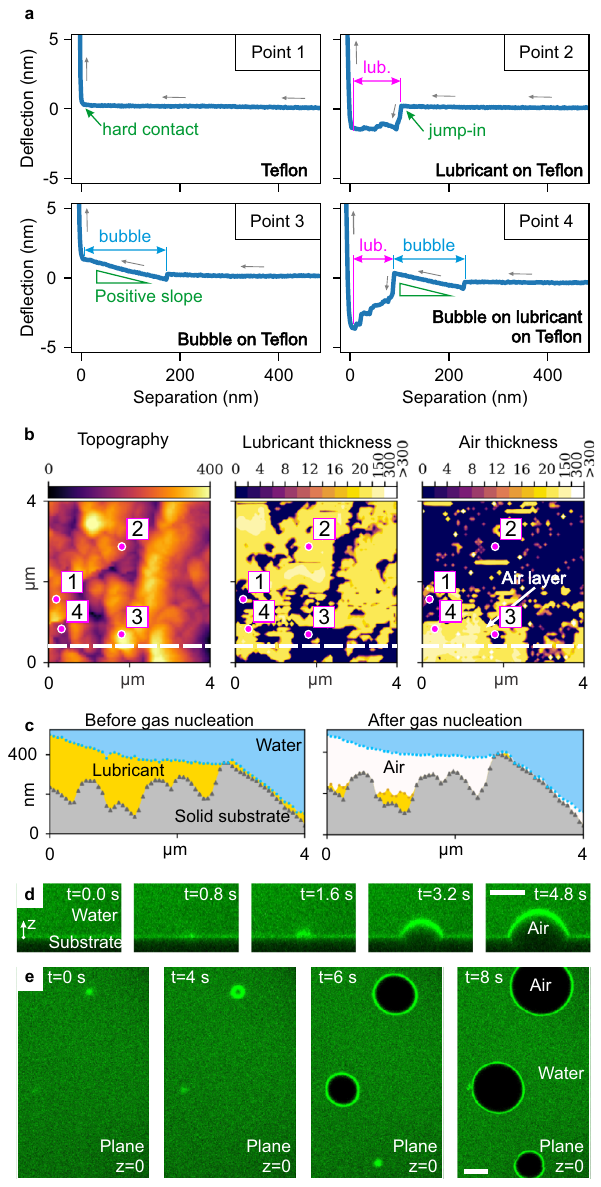
Fig. 4 Evidence of nanobubble nucleation on lubricant-infused surfaces under water. a Atomic force microscopy (AFM) force curves indicating the de fl ection of the cantilever in the points marked on part ( b ). b AFM map of an infused Te fl on-wrinkled surface under Milli-Q water ( c air ~ 23.0 ± 0.3 mg kg − 1 ). The left panel shows the topography of the wrinkles; the middle shows the thickness of the lubricant and the right the air layer, as calculated by the analysis script (further details are contained in “ Methods ” and in the Supporting Information) 27 . The scale bars are in nm. c Cross-sections of the wrinkled surface before (left) and after (right) nanobubble nucleation, reconstructed along the dashed line from the pro fi le in Supplementary Fig. S10a and part ( b ), respectively. Colors have been added to represent the different phases. d Laser confocal microscopy time-lapse of oil-infused Te fl on wrinkles in the presence of highly gassed water with c air ~ 65 ± 7 mg kg − 1 , showing the nucleation of a bubble over time. e Top view of bubble nucleation process over multiple sites. Scale bars are 25 μ m. The full-time sequence is shown in Supplementary Fig. S9. Source data are provided as a